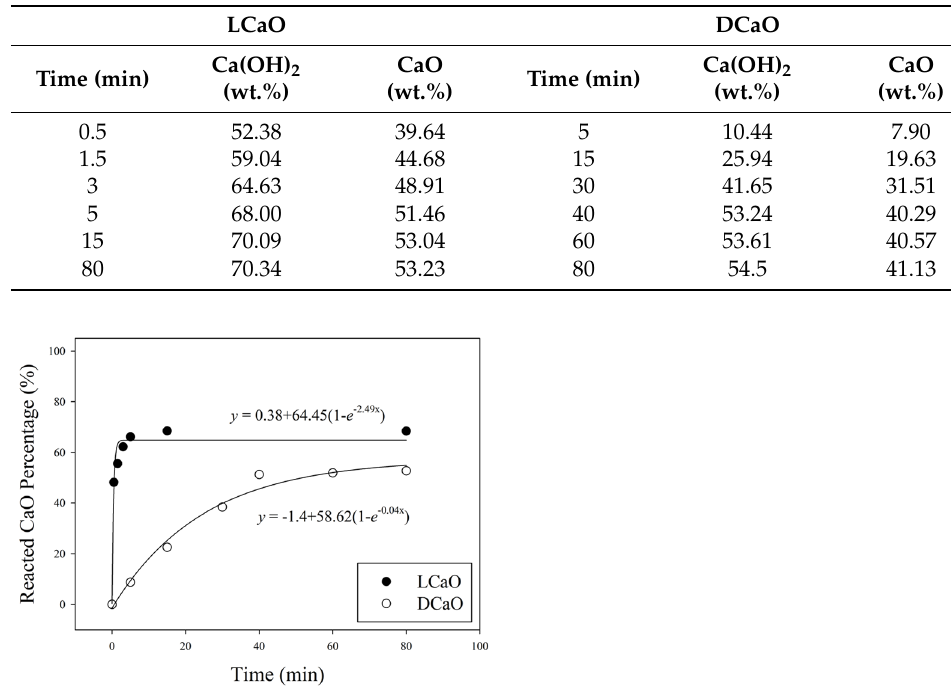
Figure 3. Effect of different calcinated temperature CaO on the hydration reaction curve.